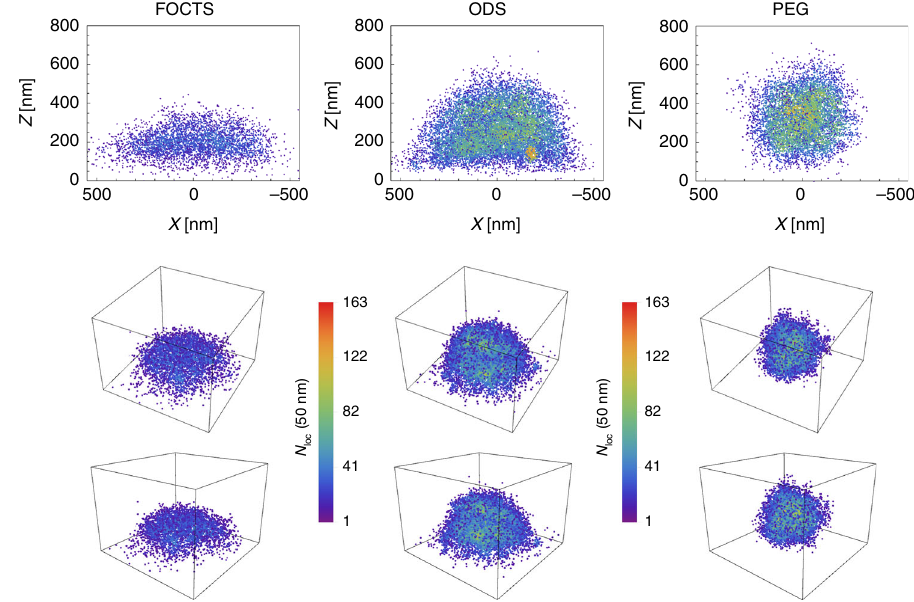
Fig. 5 Adsorbed pNIPAM microgels on surface-functionalized glass imaged with three-dimensional dSTORM 103 . The upper graphs show a vertical section ( y plane) of the localization-density distribution. The lower graphs show three-dimensional renderings at two different viewing angles. The functionalization with hydrophobic trichloro-(1H, 1H, 2H, 2H-per fl uorooctyl)silane (FOCTS), or n-octadecyltrimethoxysilane (ODS), results in a fl attened lens-like shape, while on surfaces functionalized with hydrophylic O-(2-aminoethy)polyethylene glycol (PEG), the microgel particles retain their spherical shape in agreement with the data reported previously in ref. 58 and shown in Figs. 3 and 4. The fi gure was reproduced with permission from ref. 103 (Copyright American Chemical Society, 2019).